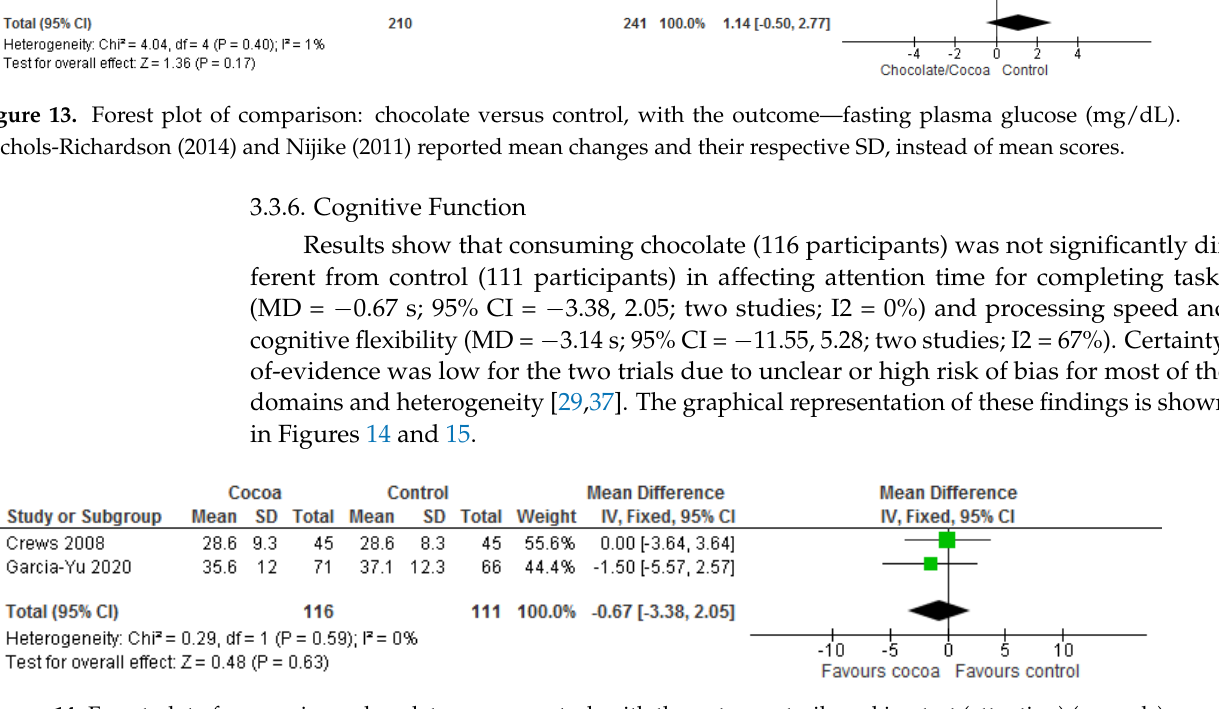
Figure 15. Forest plot of comparison: chocolate versus control, with the outcome — trail marking test (processing speed and cognitive flexibility) (seconds). Several other different cognitive function parameters were also reported by the same two studies [29,37]. However, all of these outcomes were distinctively different from each other (i.e., not suitable to be pooled) and, therefore, did not show any significant differ- ences in all the outcomes measured. There were an additional five cognitive function tests: (a) selective reminding test (nine parameters: immediate free recall, long-term storage, short-term recall, long-term retrieval, consistent long-term retrieval, random long-term retrieval, cued recall, delayed free recall and delayed recognition), (b) Ctroop Colour and Word test (three parameters: word, colour and colour-word), (c) Wechsler Memory Scale- III (two parameters: Faces I, Faces II), (d) Wechsler Adult Intelligence Scale-III (digit sym- bol), and (e) Activation-Deactivation Adjective Check List (general activation subscale) [37], with additional cognitive function parameters on working memory [29], and, there- fore, did not show any significant differences in all the outcomes. The graphical represen- tations of all above findings are shown in Figures S9–S25. 3.3.7. Quality of Life Only one study [29] measured quality of life and, therefore, did not show any signif- icant differences in all the outcomes measured, which consist of five dimensions evaluated in the EQ-5D-3L (mobility, self-care, usual activities, anxiety/depression and pain/discom- fort). The graphical representations of all above findings are shown in Figure S26. 3.4. Safety Assessment Safety assessment (as analysed based on withdrawals and adverse effects across tri- als) is descriptively summarised in Table 2. Six studies did not provide any information on reasons for withdrawals or adverse effects [32,35,36,40,41,43]. Three studies [29,30,33] addressed withdrawals but did not specifically report the safety assessment throughout the trials. In these three articles, one dropout case was reported due to gastrointestinal disturbances caused by chocolate [33]. The remaining six studies reported on safety assessment. Two studies reported that cocoa flavanol supplementation or cocoa powder is well tolerated without any subjective adverse events. No significant changes in serum biochemistry, haematologic indices, and urinalysis (plasma total protein, albumin, uric acid, free fatty acids, phospholipids, total